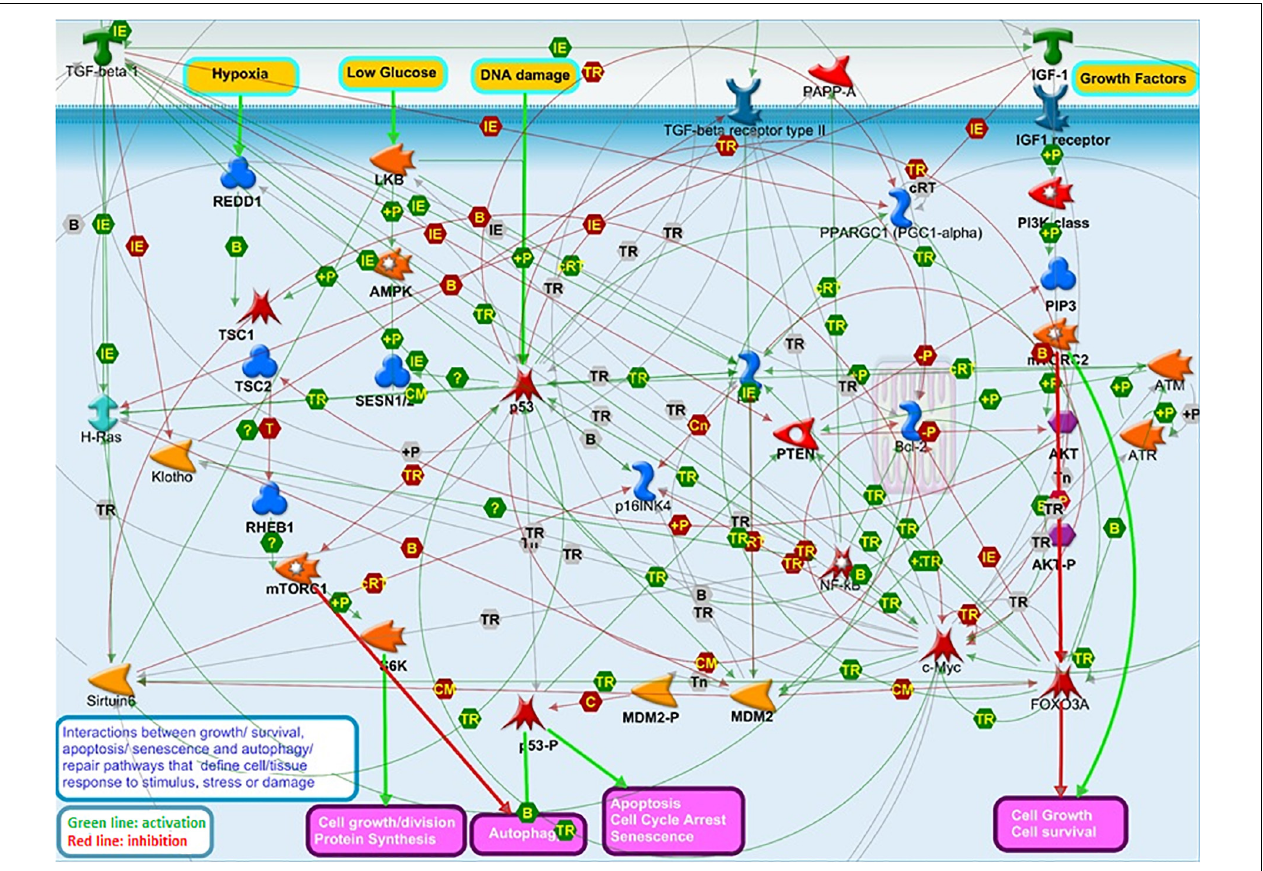
FIGURE 2 | The interplay among “aging” pathways that have been a major focus of aging research over the last decades: IGF1/AKT/FOXO3 growth signaling, TP53/P21/P16 apoptosis and senescence, and mTOR/S6K autophagy and survival pathways. This Figure illustrates the complexity of the interactions between these pathways regulating cell responses to stress and damage, which may in turn impact tissue resilience, and, ultimately, influence organismal survival and lifespan. This Figure was prepared using MetaCore Pathway Map Creator (PMC) tool (Dubovenko et al., 2017) from Clarivate Analytics . The PMC allows to connect gene products selected by the user in a picture showing the molecular interactions occurring between members of respective cellular processes and pathways. The latter are defined, annotated, and manually curated by Clarivate Analytics scientists based on the up-to-date literature and pathway libraries. Main protein classes shown on Figure 2 are annotated in Supplementary Table 3